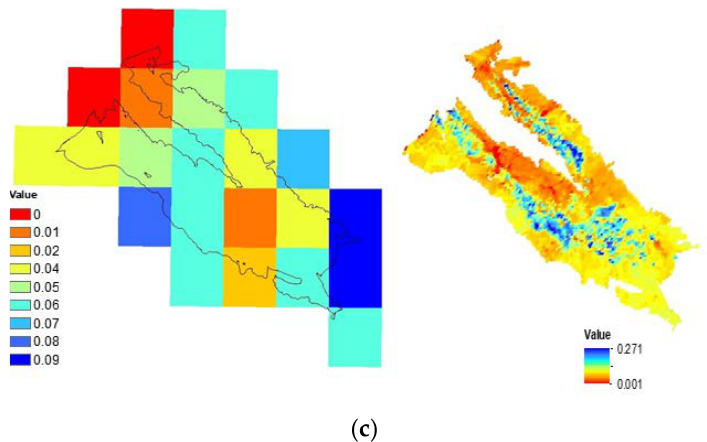
Figure 4. The conventional AMSRE (Left) and downscaled AMSRE (Right) SSM maps of the Rafsanjan plain on ( a ) 19-09-2017, ( b ) 01-01-2018, ( c ) 08-07-2018, and ( d ) 8/29/2018. In the above equation, θ s represents downscaled SSM. A, T, and V represent albedo, LST, and NDVI, respectively. The remainder is A-T-V interactions (i.e., TA, VA, and VT).